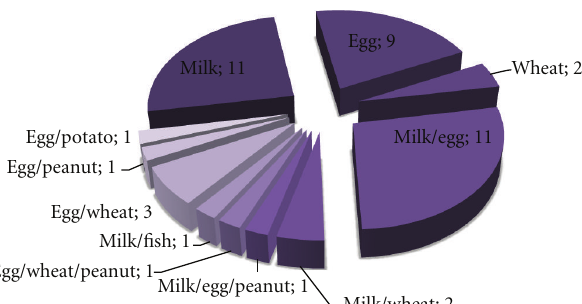
Figure 4: Sensitization to food allergens (absolute numbers of sen- sitized infants) in the group of symptomatic infants at 12 months of age ( n =